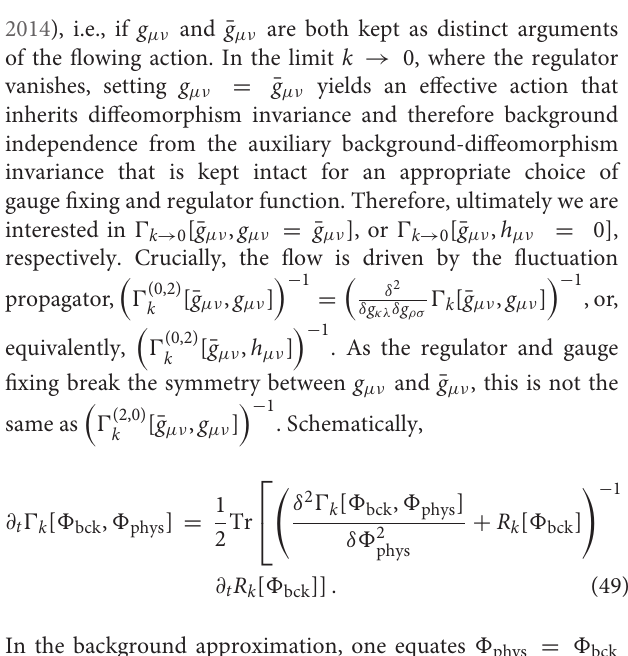
Critical exponents can be split into the two sectors, as the background couplings do not couple into the flow of the dynamical couplings and accordingly the stability matrix is upper/lower triangular in the background sector yielding canonical